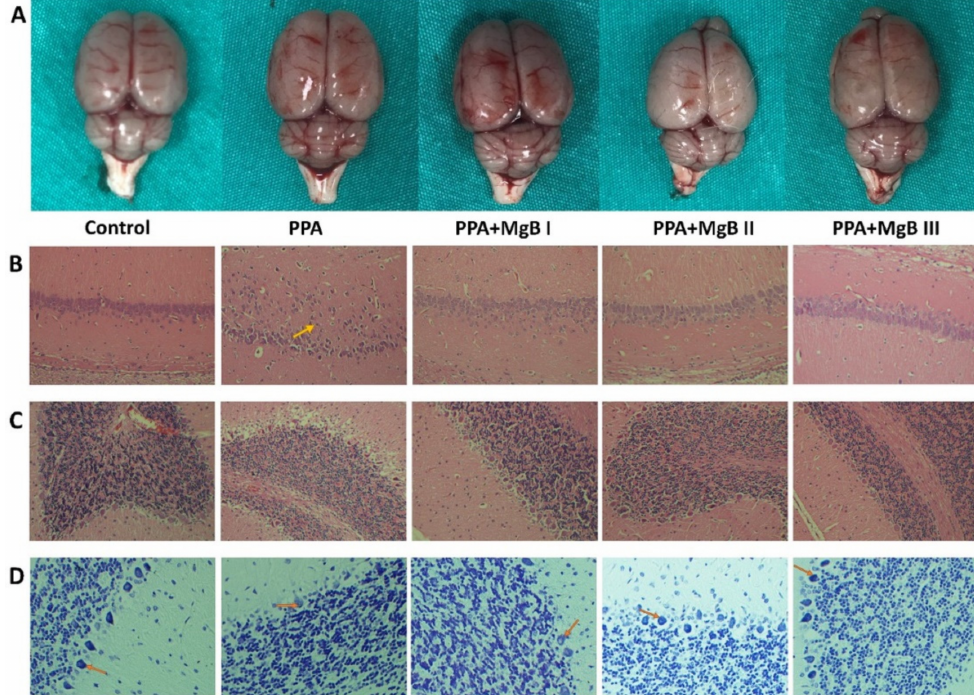
Figure 1. ( A ) Effects of MgB supplementation on macroscopy of the brain in PPA-induced autism in rats. ( B ) Effects of MgB supplementation on the histopathology of the hippocampus CA1 fields (H&E 200 × ) in PPA-induced autism in rats. There was granule cell layer thickness in the hippocampus of PPA-exposed rats. Treatment with MgB at different doses ameliorated this reduction in the PPA- exposed rats. ( C ) Effects of MgB supplementation on the histopathology of the cerebellum (H&E 200 × ) in PPA-induced autism in rats. Reduction in the number of Purkinje cells, nucleus density, edema of Purkinje layer, and cytoplasmic edema of Purkinje layer was observed in PPA- exposed rats. Treatment with MgB ameliorated these alterations in the PPA-exposed rats. ( D ) Effects of MgB supplementation on Nissl staining of the hippocampal CA1 fields (400 × ) in PPA-induced autism in rats. The number of Nissl-positive cells was reduced in the hippocampal CA1 region of PPA- exposed rats compared to the control group. Treatment with MgB ameliorated these changes in the PPA-exposed